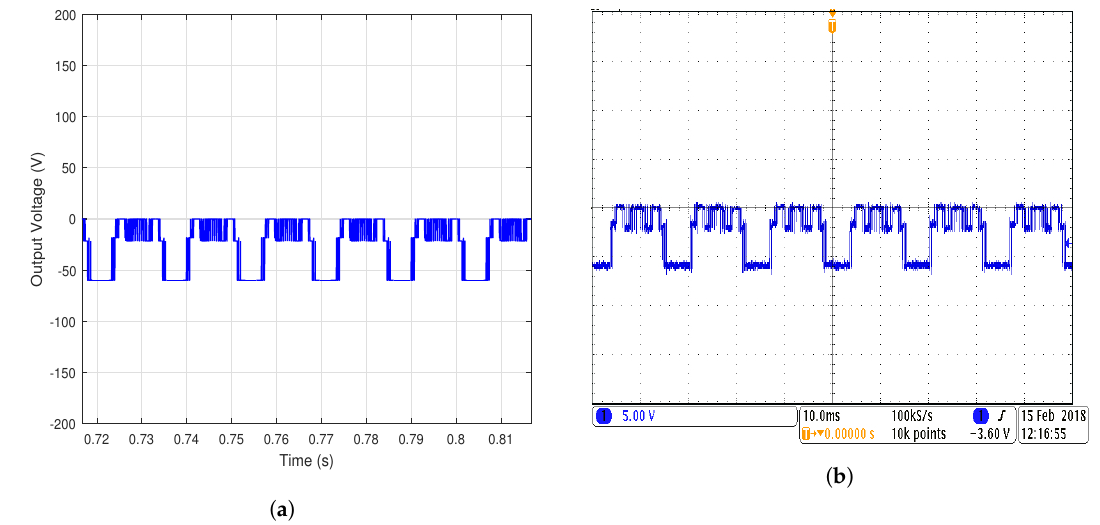
Figure 13. Results of seven-level SS MLI: ( a ) simulated V no voltage; ( b ) experimental V no